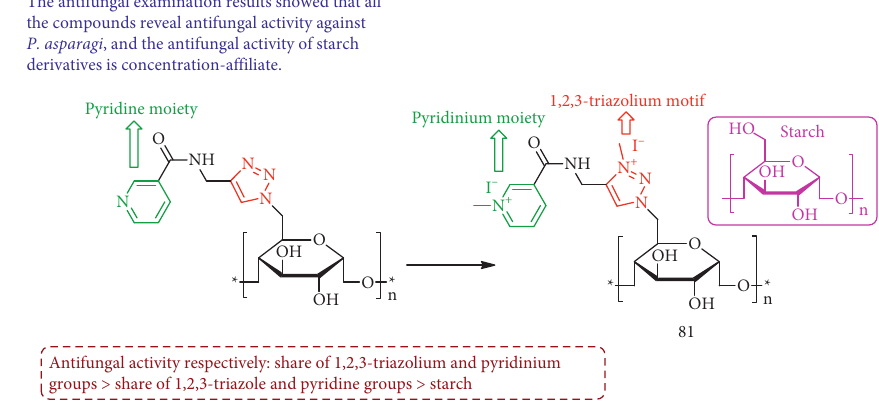
Figure 32: Chemical structure of novel starch derivative bearing 1,2,3-triazolium and pyridinium.